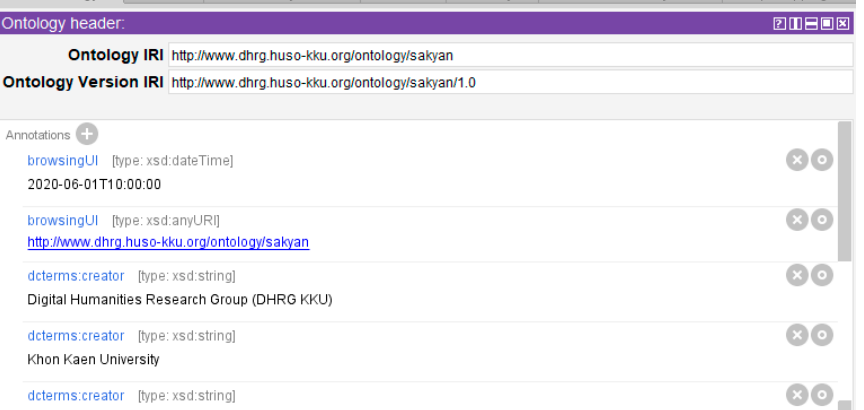
Figure 11. License declaration.